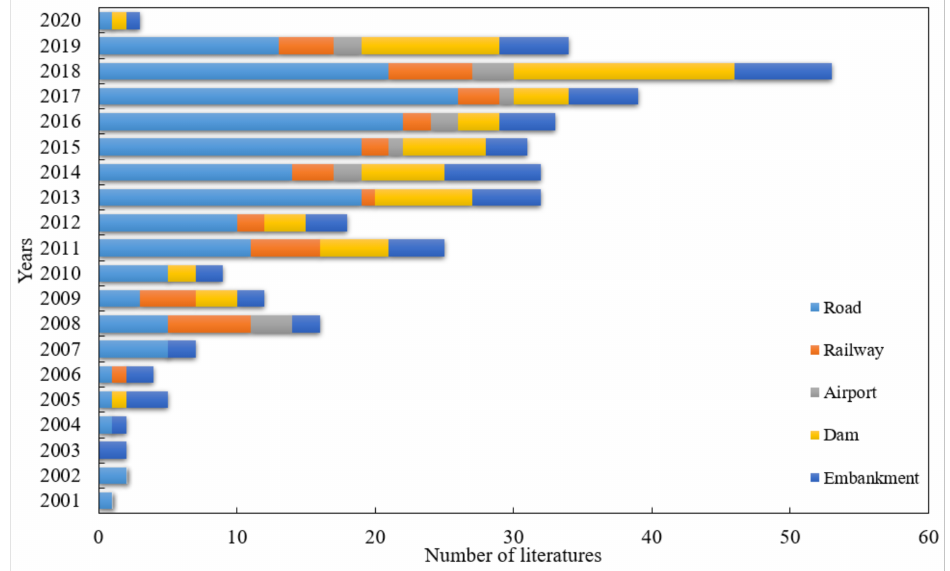
Figure 2. Published literature related to the QC/QA methods for